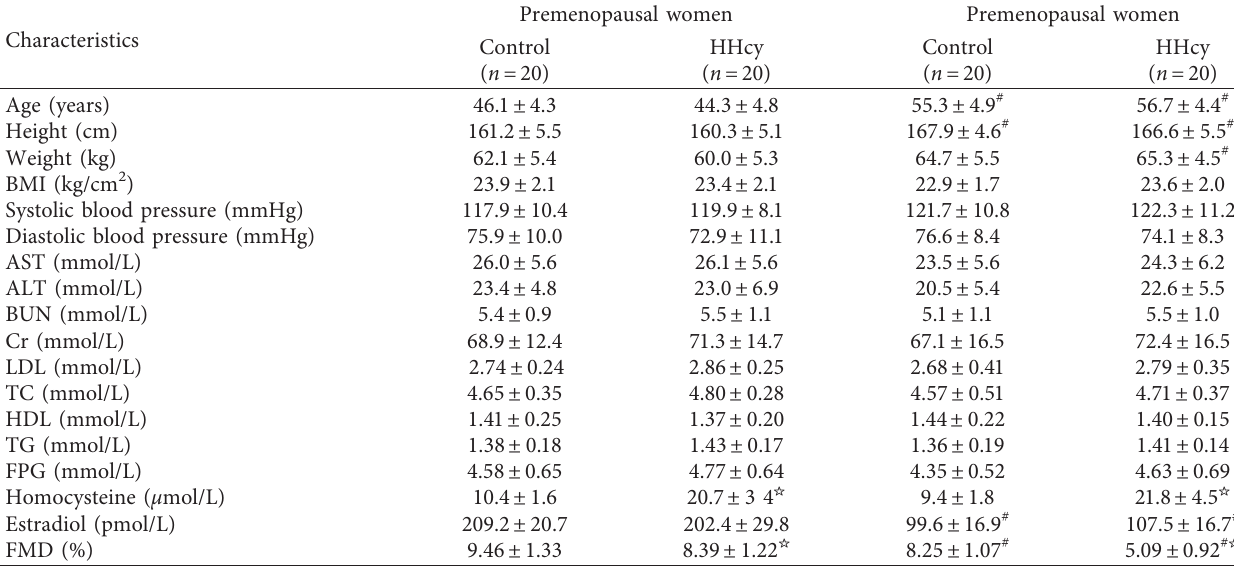
Table 1: Clinical and biochemical characteristics.